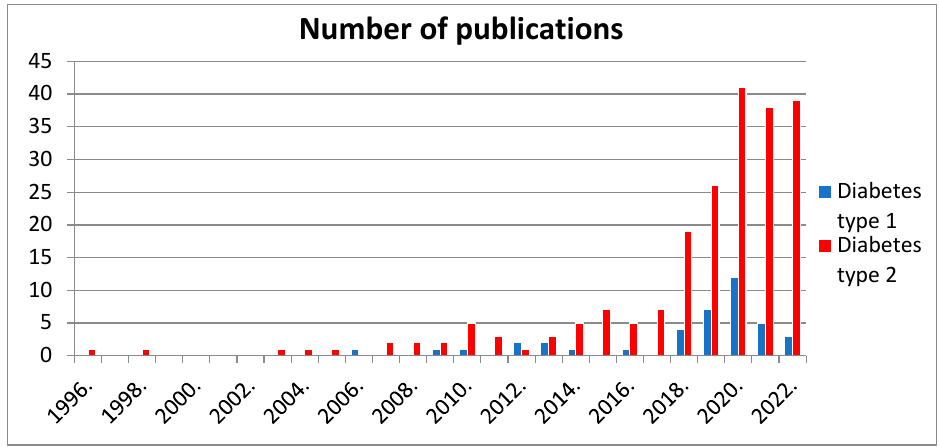
Figure 1. Comparison of the number of publications in the PubMed search engine for type 1 diabetes (phrases: “ketogenic diet and diabetes type 1”; “ketogenic diet and type 1 diabetes”; “ketogenic diet and T1DM”; “ketogenic diet and autoimmune diabetes”) and type 2 diabetes (phrases: “ketogenic diet and diabetes type 2”; “ketogenic diet and type 2 diabetes”; “ketogenic diet and T2DM”).